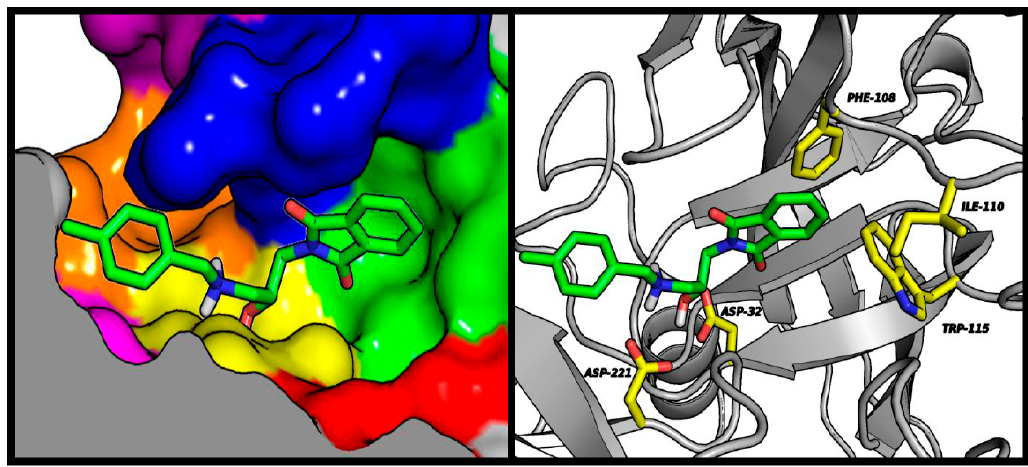
Figure 5. Left panel: illustrative location of compound 6 (green sticks) in the active site of BACE-1. Active site elements are color-coded: S3 ′ : violet; S2 ′ : orange; S1 ′ : magenta; S1: yellow; S2: blue; S3: green; S4: red. Right panel: detailed visualization of compound 6 (green sticks) interactions with amino acids (yellow) belonging to the active site of BACE-1.